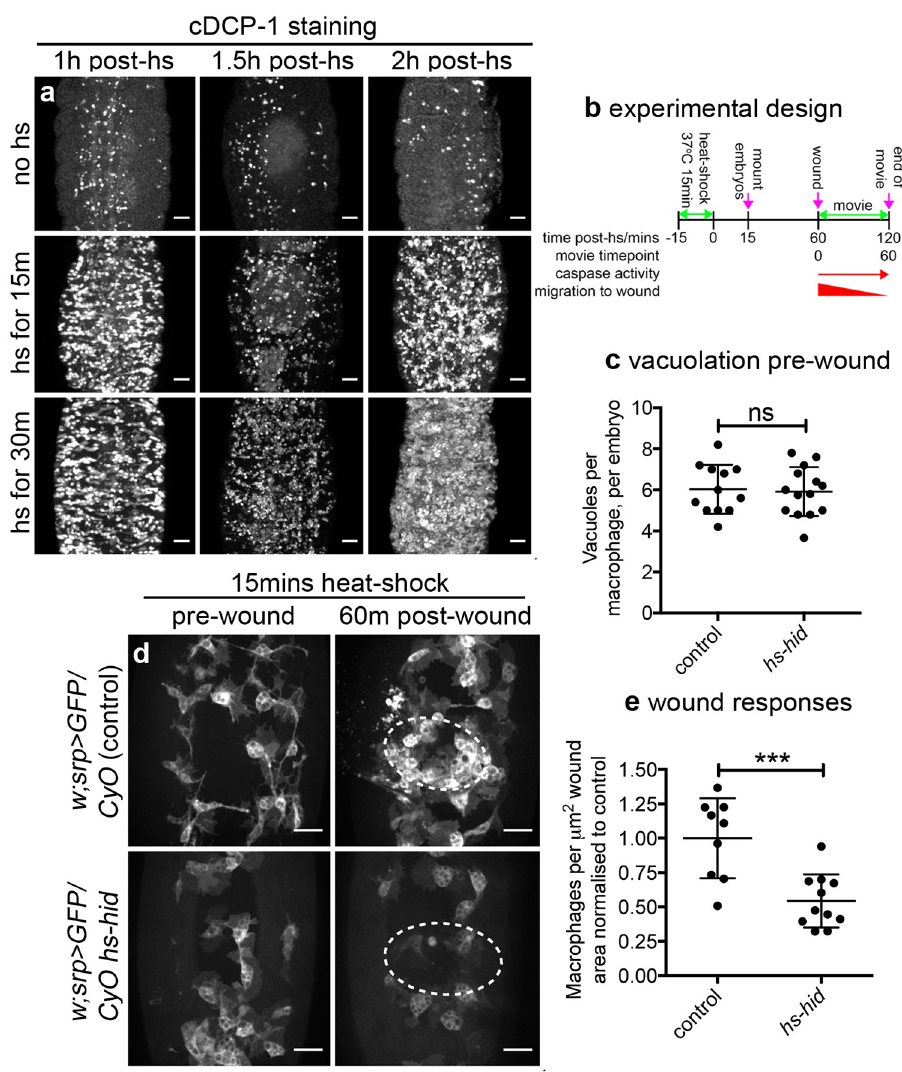
Fig 5. Acute induction of apoptosis impairs inflammatory responses without the requirement for engulfment by macrophages. (a) Ventral projections of embryos containing hs-hid ( w;CyO hs-hid/+ ) stained for active caspases (anti-cDCP-1) following heat-shock for 0, 15, or 30 minutes; embryos fixed and stained at indicated times. (b) Schematic showing experimental design to induce exogenous apoptosis ahead of clearance by phagocytes in the embryo. (c) Scatterplot showing vacuoles per macrophage, per embryo as a read out of phagocytosis at 60 minutes post heat shock (immediately before wounding) in control and hs-hid embryos ( n = 12 and 14, respectively; P = 0.829, Mann–Whitney test). (d) Prewound and 60-minute postwound ventral views of control ( w;srp-GAL4 , UAS-GFP/CyO ) and hs-hid embryos ( w;srp-GAL4 , UAS-GFP/CyO hs-hid ) subjected to 15-minute heat-shock; experimental design was as per (b), with wounding taking place at 60 minutes post heat shock. Dotted lines show wound edges. (e) Scatterplot of wound responses (density of macrophages at wound sites normalised to wound area and to control average) at 60 minutes post wounding of control and hs-hid embryos ( n = 9 and 11, respectively; P = 0.0005, Mann–Whitney test). Line and error bars show mean and standard deviation in all scatterplots; ns and ��� denote not significant and P < 0.001; scale bars represent 20 μ m. All data used to plot graphs may be found in Supporting information file S1 Data. cDCP-1, cleaved death caspase 1; GFP, green fluorescent protein; UAS, upstream activating sequence.